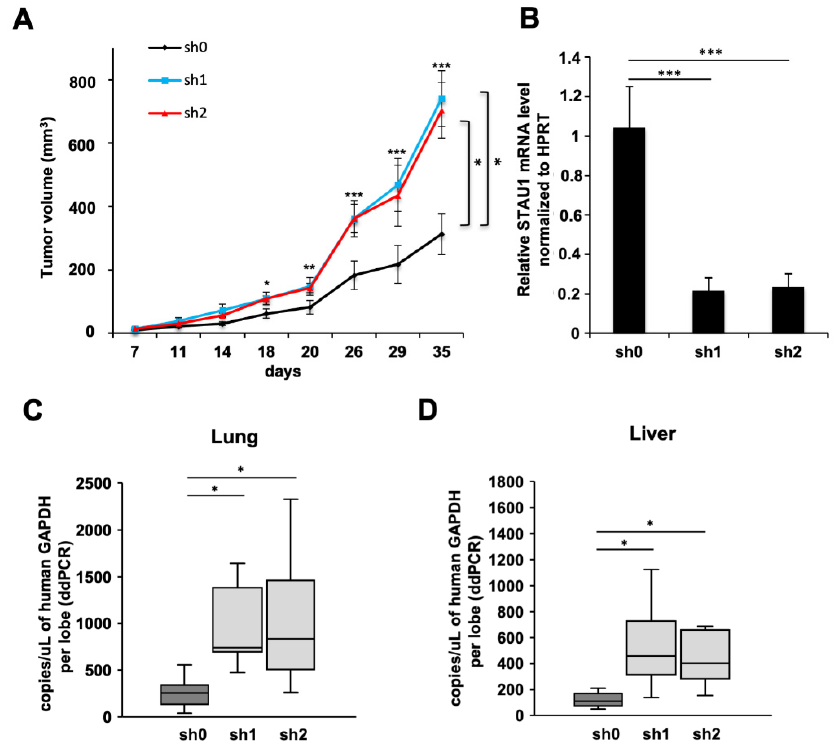
Figure 4. Stau1 depletion favors tumor progression and metastasis properties. ( A ) Tumor volumes measured at the indicated time points after subcutaneous injection of Stau1-deficient or control H460 cells into nude mice (statistic test: ANOVA + Turkey correction. sh0 vs. sh1 p = 0.0106; sh0 vs. sh2 p = 0.0244; sh1 vs. sh2 p = 0.965. * p < 0.05). Error bars show SEM. ( B ) Tumors were collected after 35 days and Stau1 mRNA level was controlled by RT-PCR after RNA extraction. ( C , D ) Tumor metastasis was evaluated by ddPCR by measuring human GAPDH mRNA levels in lung ( C ) and in liver ( D ). (Asterisks: * p < 0.05; ** p < 0.01 and *** p < 0.001 in two-tailed Student’s t-test).